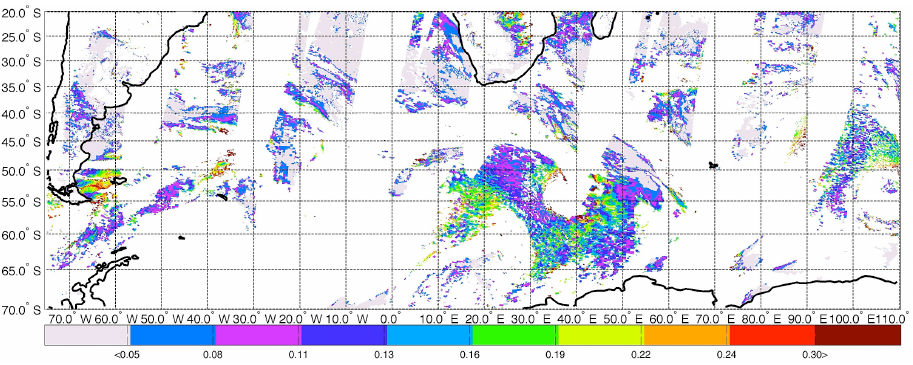
Fig. 6. Hemispherical map aerosol optical depths from Terra MODIS on 26 February 2005. Note the adjustment of color scale by setting maximun at 0.3 in order to emphasize the variable low aerosol concentrations. The dust event from Tierra del Fuego is visible with AOTs > 0.24 (see text).